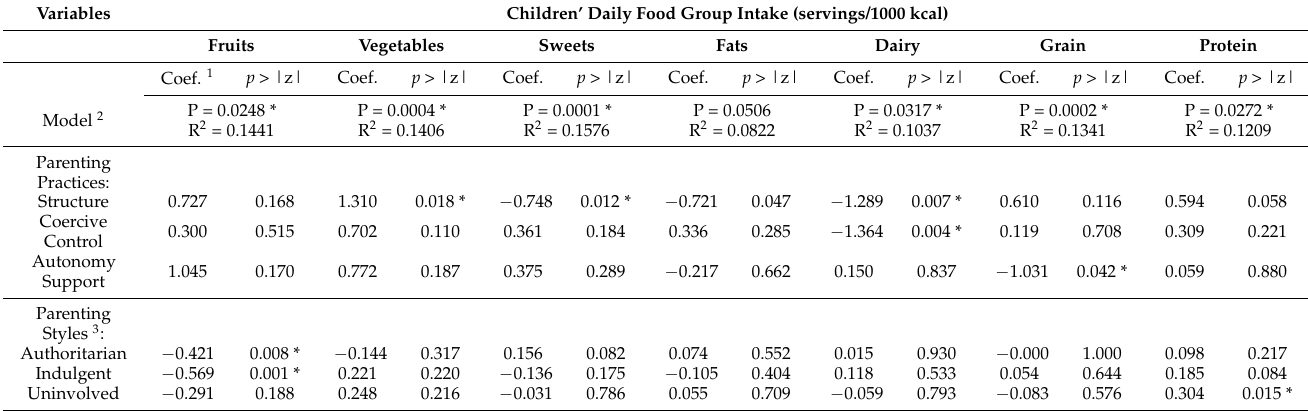
Table 4. Adjusted regression models for children’s daily food group